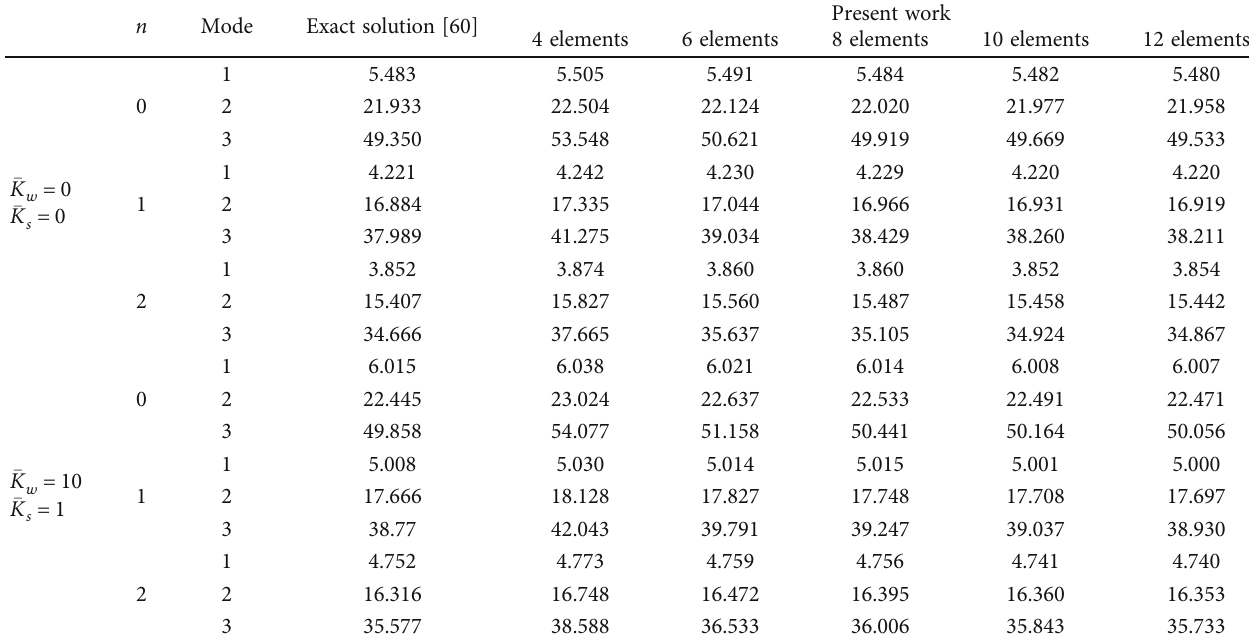
̂ K L / h w = 10 , s = 1 , and